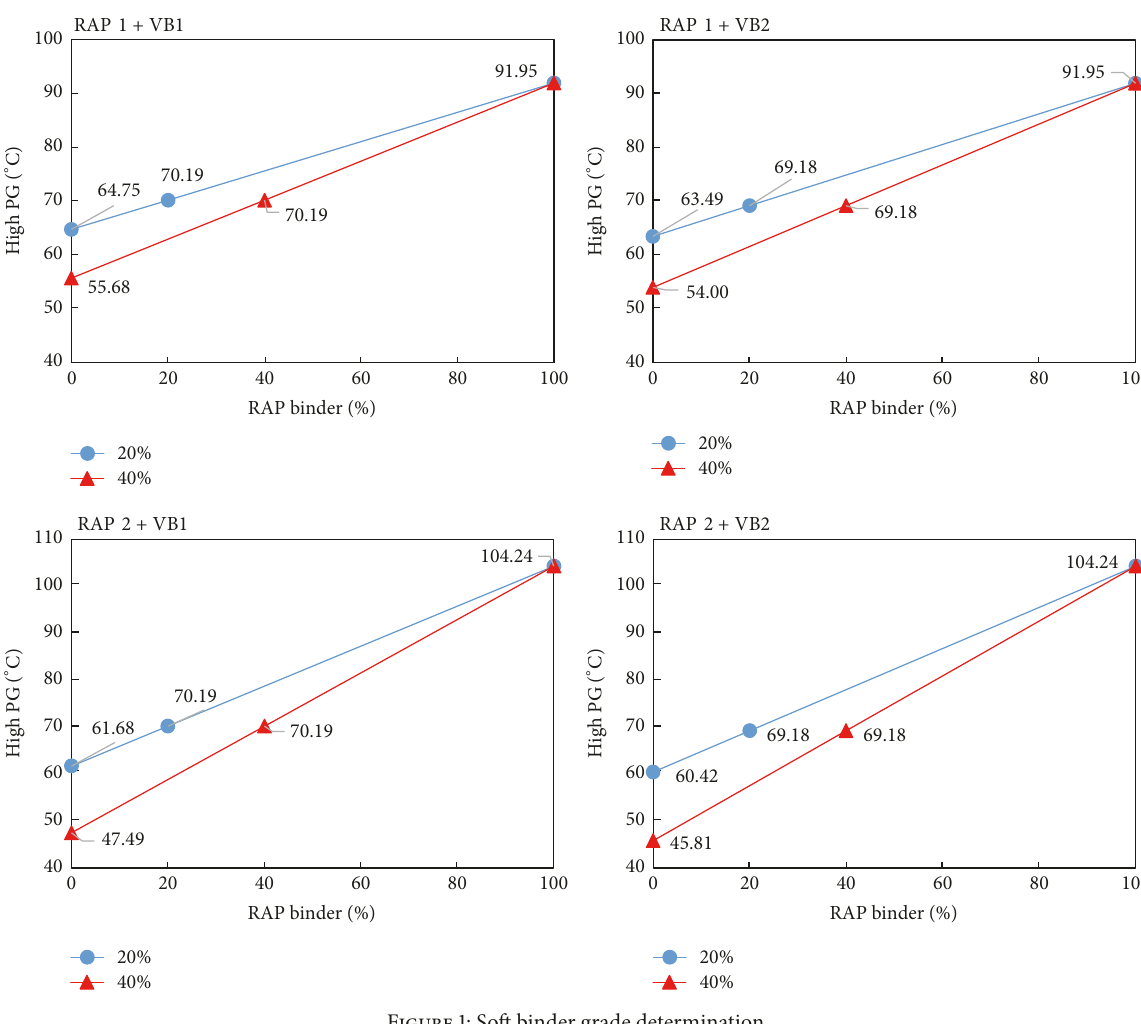
Figure 1: Soft binder grade determination.